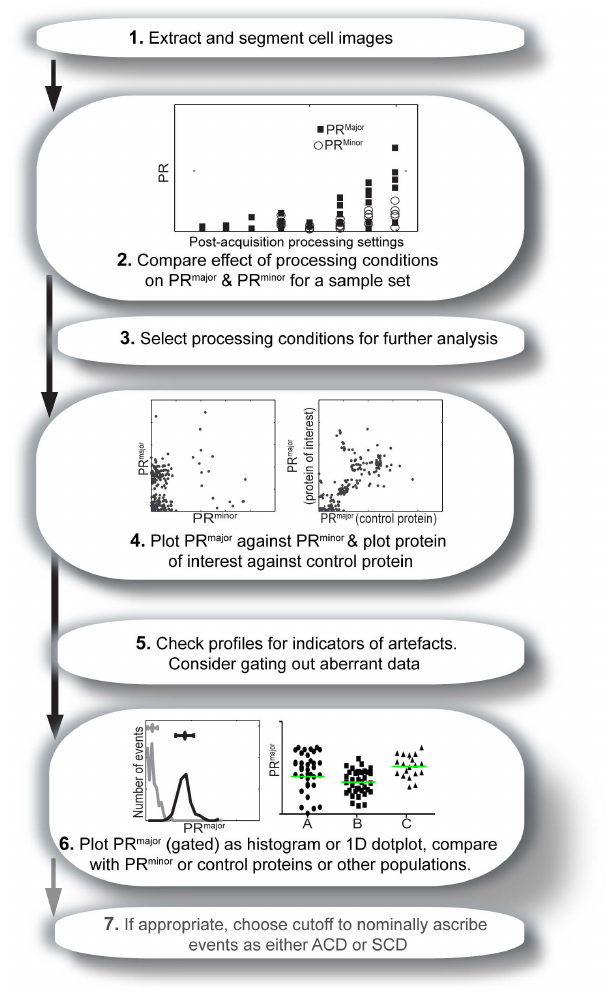
Figure 8. Suggested workflow for optimal analysis of ACD. A method of analysis that avoids some pitfalls of polarity measurement as illustrated in this study begins with ( 1 ) extraction and segmentation of images, including demarcation of major and minor axes (either using the long axis as demonstrated here, or alternative strategies). ( 2 ) A randomly selected sample set of the data should be used to plot PR major and PR minor against a range of processing settings, and used to ( 3 ) determine the optimal processing settings that avoid artificially high PR values (as indicated by PR minor analysis) but provide good dynamic range of PR major (see the discussion of Fig 4 for an illustration of this process) ( 4 ) The optimal processing settings are used to plot PR major against PR minor for the entire population. ( 5 ) PR major vs. PR minor is utilized for exploration of the quality of the data. Firstly, assuming that polarization occurs only along one axis, the two parameters should be independent of each other and this can be evaluated from the plot both visually (as is common in flow cytometric analysis where correlations can indicate errors in cross-spectral compensation) and by regression analysis. If the plots are still linked to the original data, any outliers can be readily examined to determine possible causes of error. For instance, using an interface such as provided by the TACTICS Toolbox [23], clicking on the dots can bring up the specific frame or movie associated with that data point and possible exclusion of aberrant data such as problems with the focus. Secondly, gating for cells with low PR minor values on the plots enables exclusion of noisy data and simultaneous assessment of the extent, range and variance of PR major . ( 6 ) The gated PR major can then be plotted as a histogram or scatter plot, enabling comparison with control data or between test populations. These plots represent an endpoint of the analysis, but can also be used to determine whether additional values such as mean